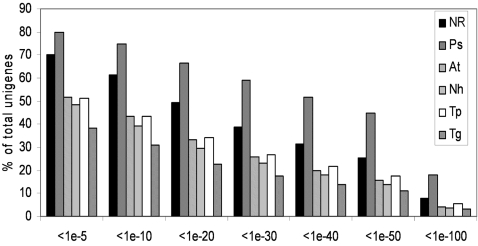
Comparison of A. euteiches sequences to the non redundant protein database at NCBI and proteomes of fully sequenced organisms.Unigene sequences were blasted using the BLASTX software to the nr database and to the proteome of P. sojae (Ps), A. thaliana (At), N. haematococca (Nh), T. pseudonana (Tp) and T. gondii (Tg). For each class of e-value the percentage of unigenes showing homology is indicated.